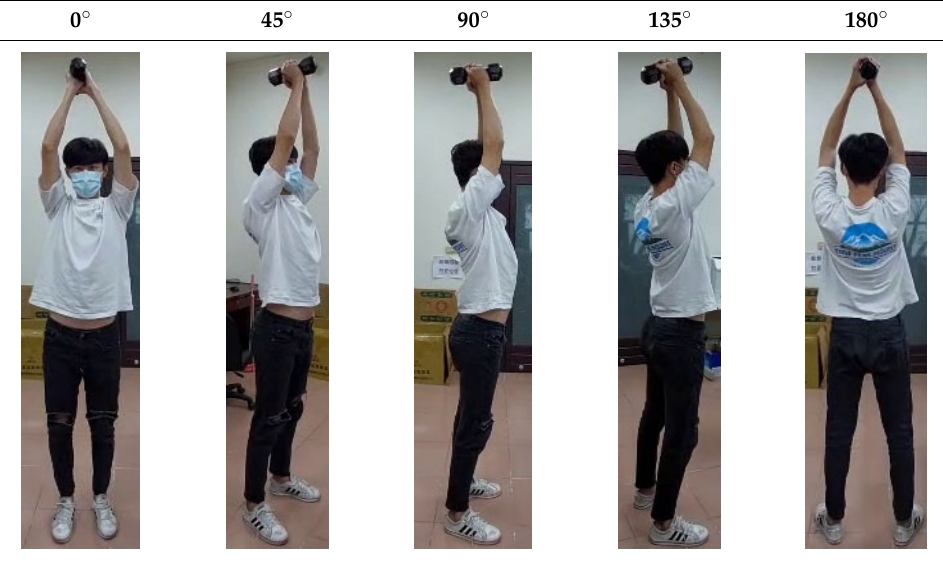
Table 4. In the image database, the shooting angle included in each fitness exercise.